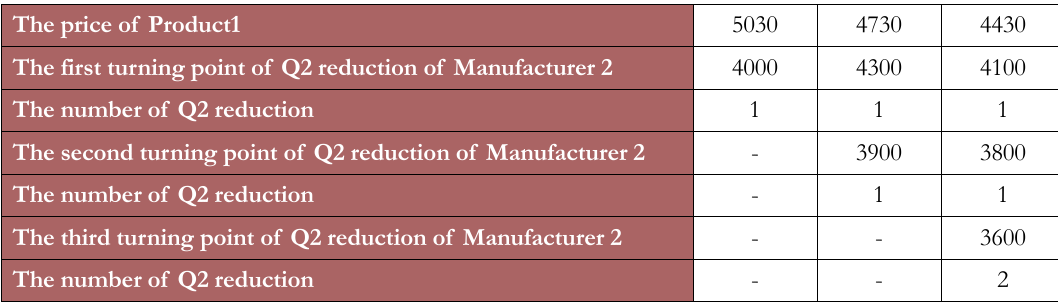
Table 8. The change of Q2 with the change of Lenovo and HP computer